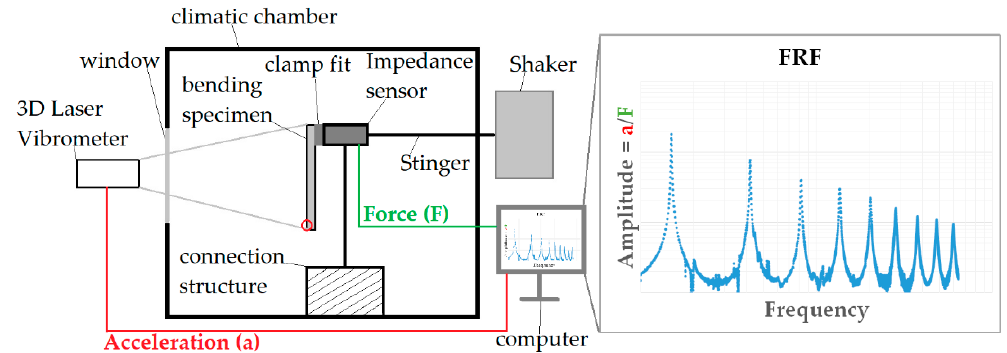
Figure 4. Principle sketch of the used bending vibration test arrangement.